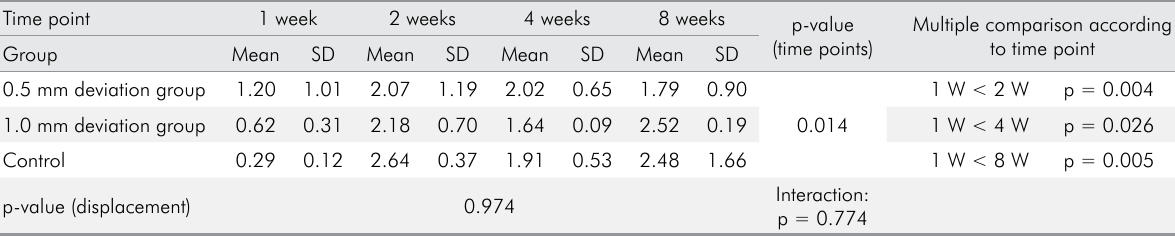
Table 1. Comparison of blood vessel volume according to time point and group.